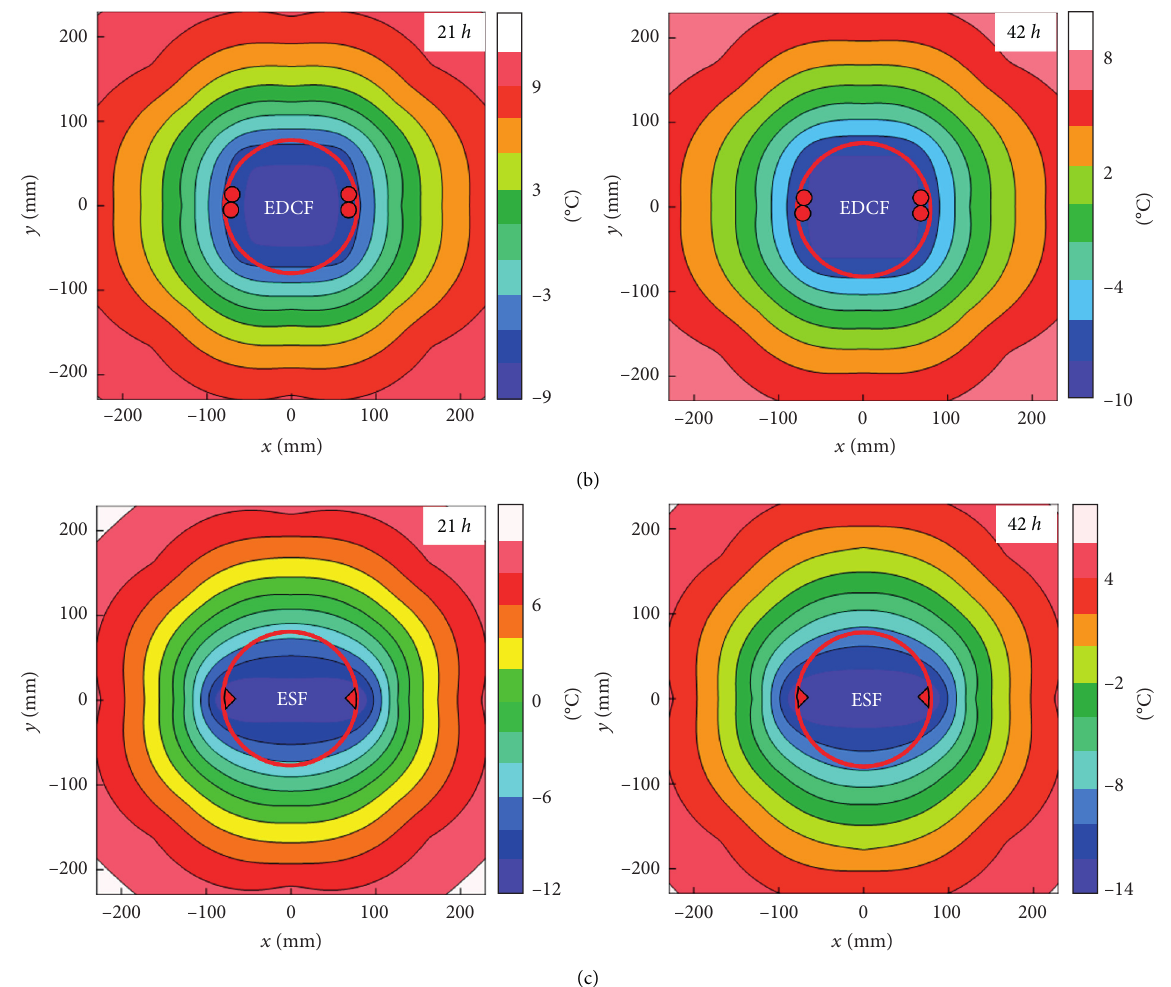
Figure 12: Temperature contour of the freeze-sealing pipe-roof: (a) SCF; (b) EDCF; (c) ESF.